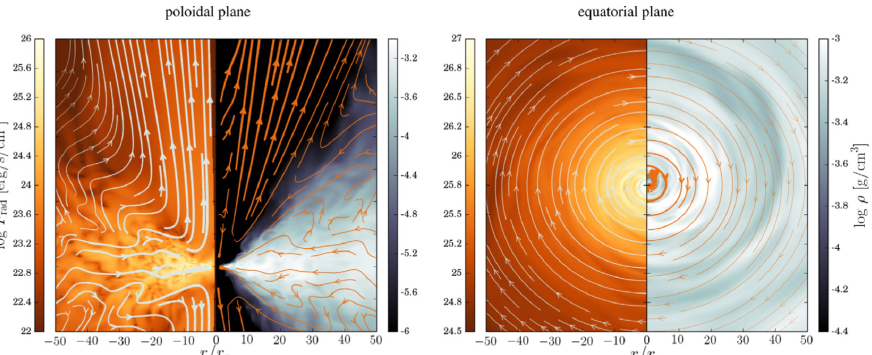
Figure 6. Snapshot images of radiative flux (left half of each panel) and density (right half of each panel) in the radiation GRMHD simulations of a thick torus. The left and right panels correspond to vertical and equatorial slices, respectively. Lines indicate azimuth- and time-averaged radiative flux and gas velocity. Figure is reproduced with permission from Sadowski and Narayan, MNRAS, 456, 3929 (2016)